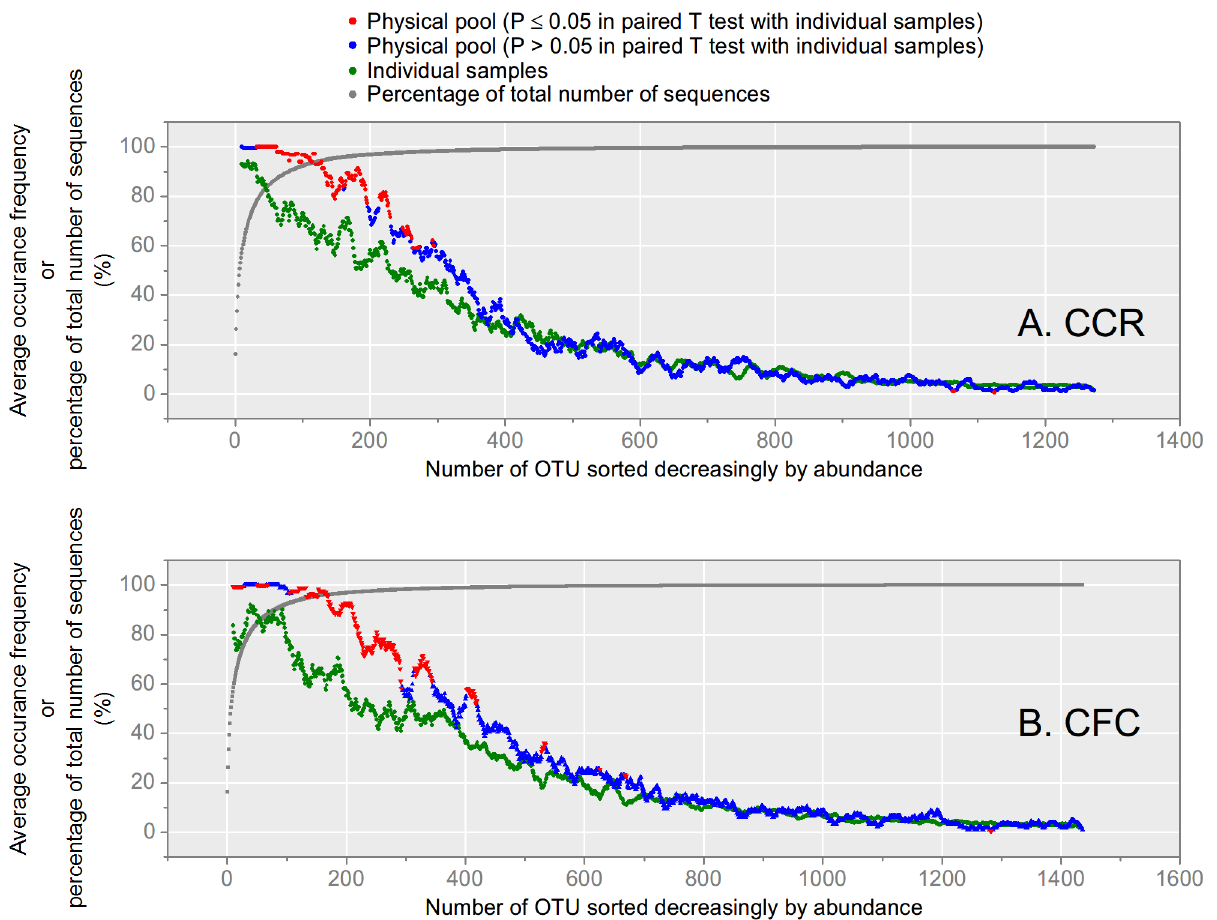
Fig 3. Average occurrence frequency of OTUs in physical pools versus individual samples, and percent of total number of sequence, moving from abundant (left) to rare (right) taxa. Physical pools are in red and blue points, individual samples are in green points, total number of sequence is in gray points. The occurrence frequency of each OTU is defined as the occurrence (sequence number (cid:1) 1) in either 9 physical pools or 24 individual pools in the form of percentage in both site. The average occurrence frequency shown in the plot was calculated as the average of 20 OTUs around each individual OTU. In the physical pool, red points indicate significant difference ( P (cid:3) 0.05) in paired T-test between physical and individual pools ( α = 0.05), while blue points were not significantly different. All T-tests were adjusted with Bonferroni correction with hypotheses n = 20. The percent of total number of sequence was defined as the sum of abundance percentage from 1 st to current OTU in descending order of